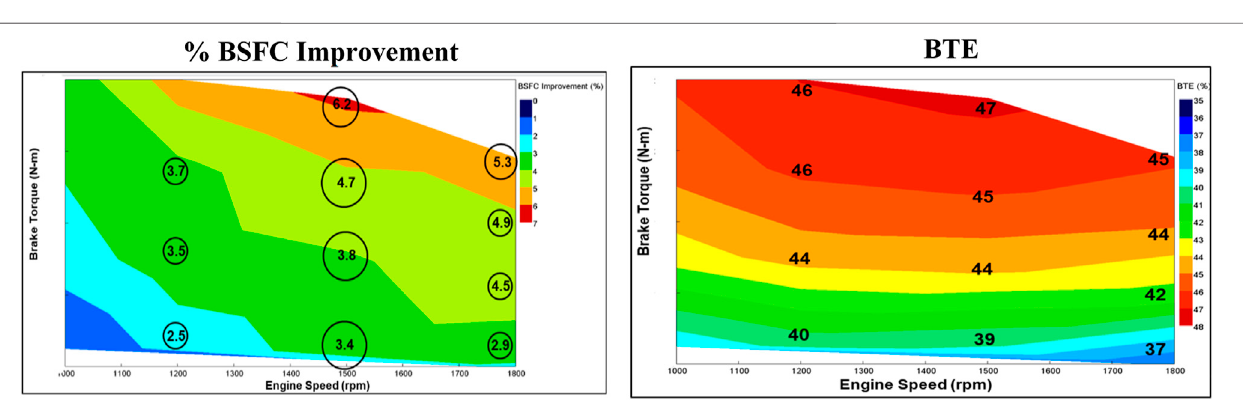
FIGURE 21 | %BSFC and BTE improvement from new engine architecture using EGR pump.